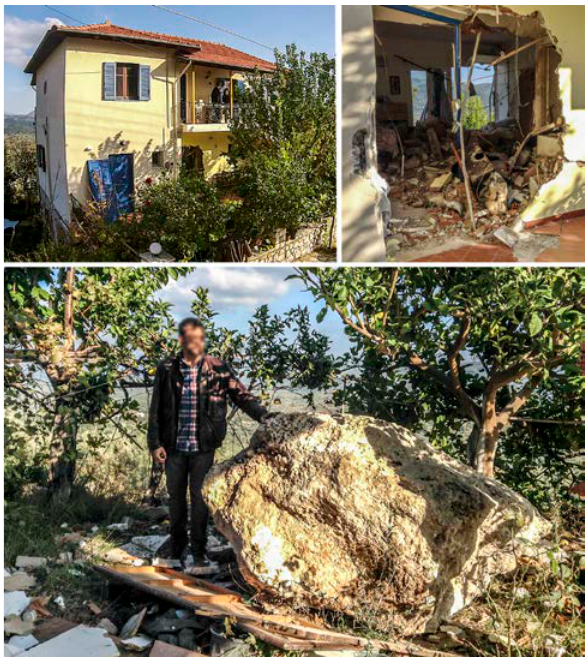
Figure 1. View of the rock block, the house it impacted near the end of its trajectory and the damage to infill walls that it caused.